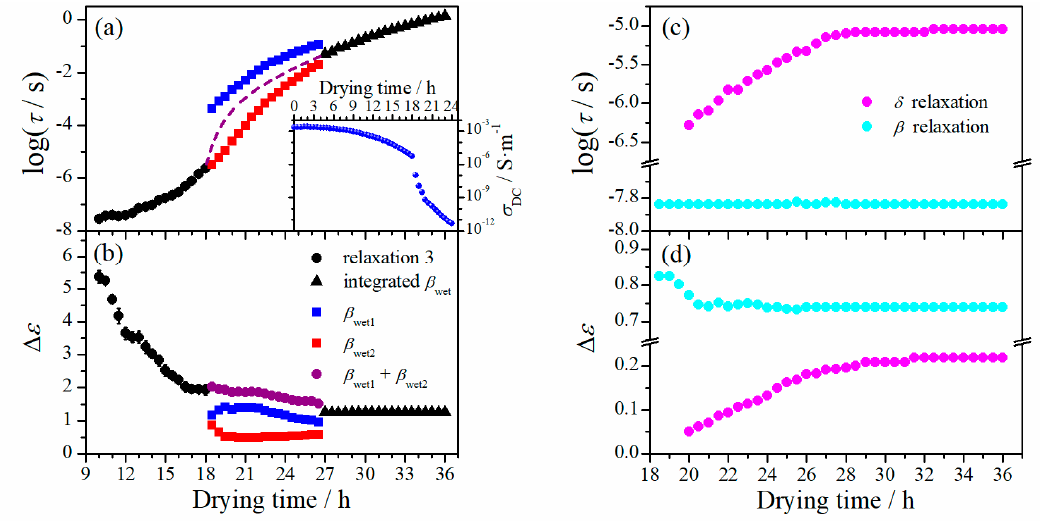
Figure 5. ( a ) Variation of the characteristic relaxation time of β wet -relaxation and dc conductivity (inset) with drying time; ( b ) variation of relaxation strength of β wet -relaxation with drying time; variation of ( c ) characteristic relaxation time and ( d ) relaxation strength of δ - and β -relaxation with drying time. The short dashed line is for guiding the eyes.